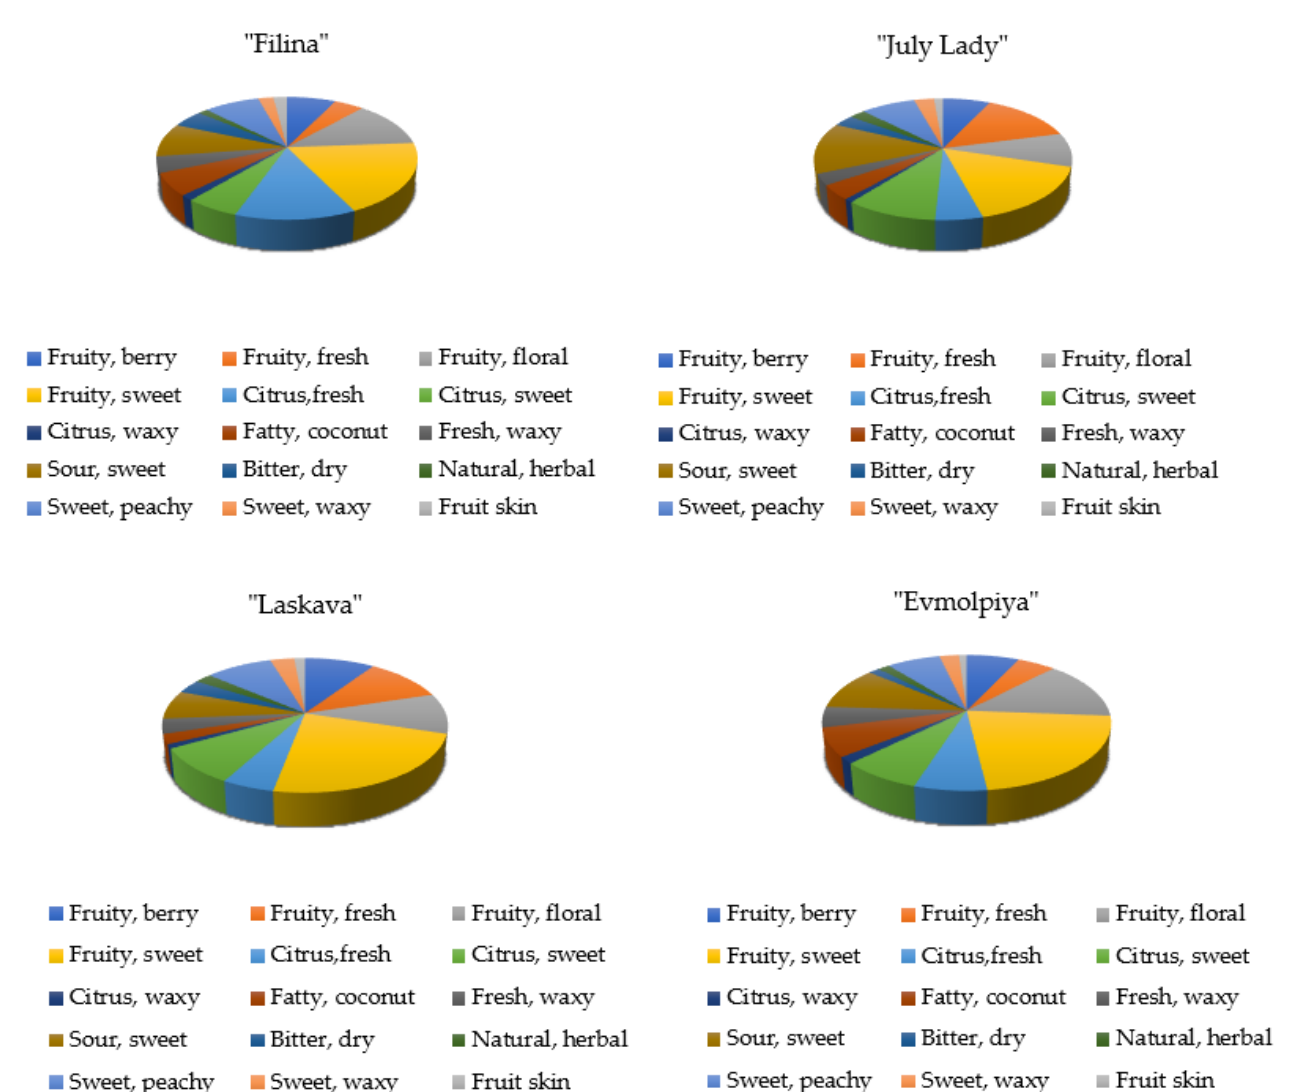
Figure 4. Flavor component distribution (%) in peach varieties.